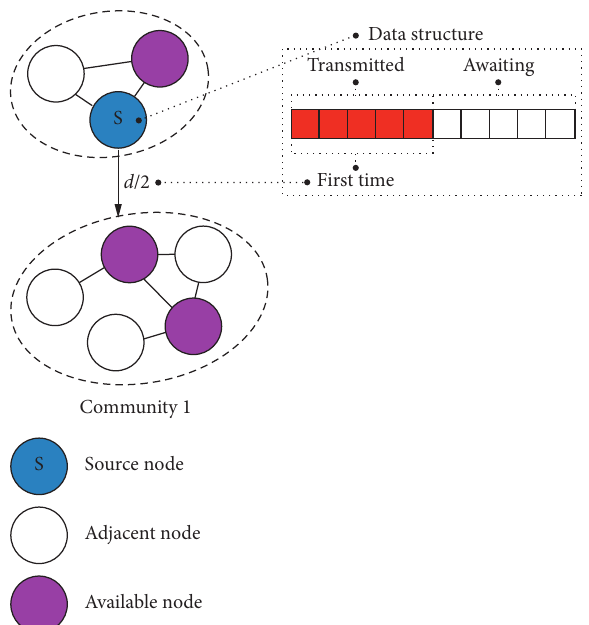
Figure 4: Information delivery and data structure in first-time